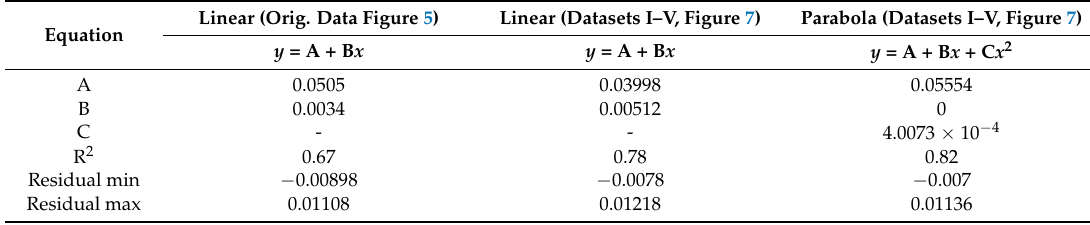
Figure 8. Residuals for parabola and linear fit.